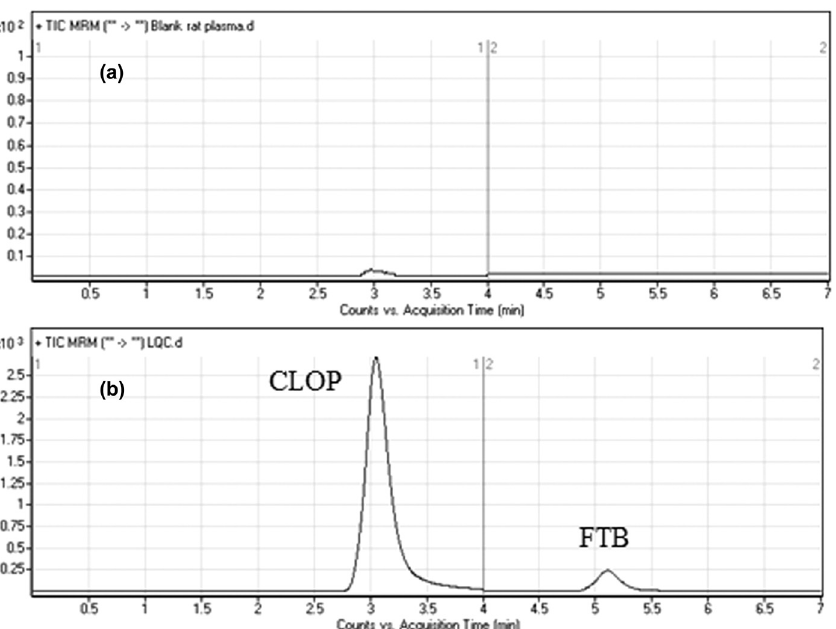
Figure 6: MRM chromatograms of ( a ) blank rat plasma and ( b ) CLOP ( 15 ng/mL; LQC ) . The blank rat plasma did not reveal any matrix interference.